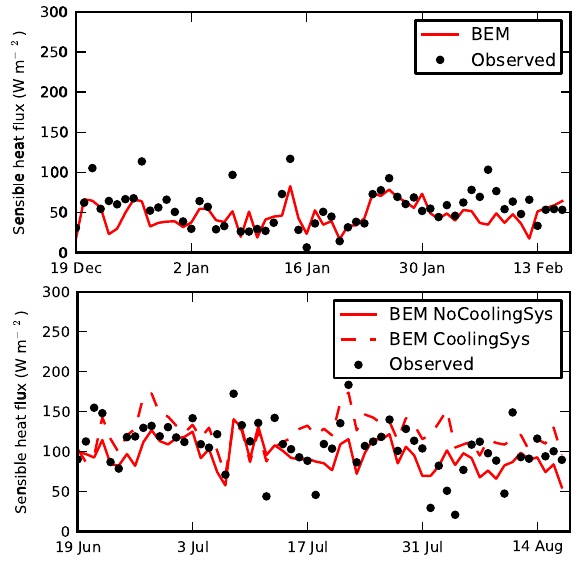
Fig. 10. Daily-average sensible heat flux per unit of urban area from observations and calculated by BEM-TEB in winter (top) and in summer (bottom) for the dense urban centre of Toulouse. For the summer case, BEM-TEB simulations consider the presence or not of operating air-conditioning systems in the urban area.